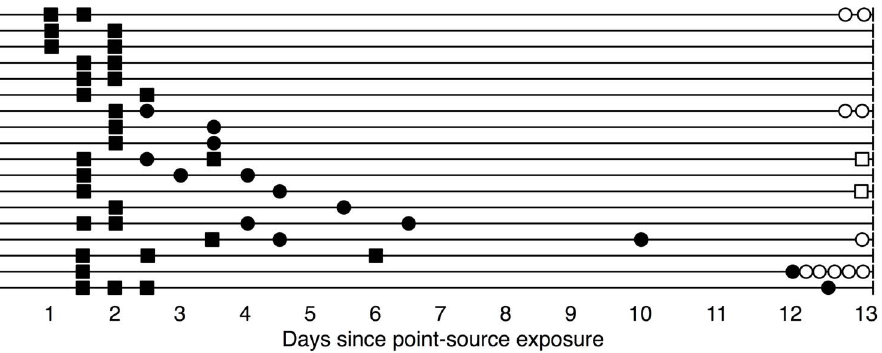
Figure 1. Observations for 18 households with non-index cases. The figure illustrates the time course of infection in the 18 households in which there was a non-index case who became ill after the onset of symptoms in the index case. Filled boxes indicate an individual who dined at the point-source and became ill. Filled circles indicate individuals who became ill and did not dine at the point-source. Hollow boxes and circles along the right margin indicate the number of individuals in the household who did and did not dine at the point source and did not become ill, respectively. The additional 52 households in the analysis with no secondary cases are not pictured.